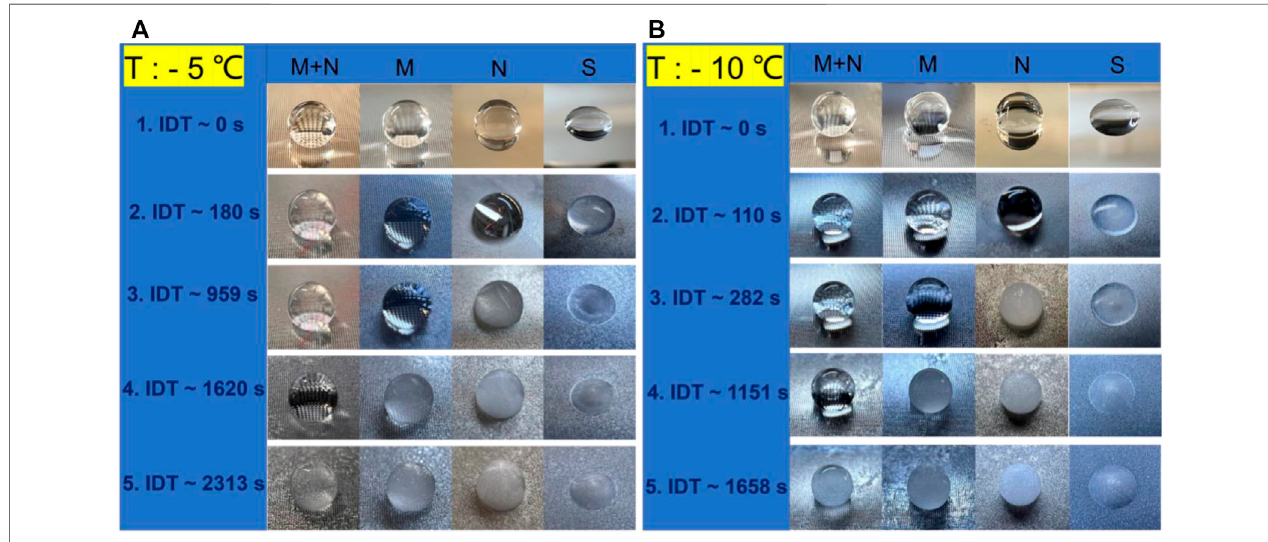
FIGURE 7 | Observations of ice formation on the differently structured surfaces at − 5 ° C and − 10 ° C cooling temperatures. From right to left are the photos of the droplets on the surfaces of S, N, M, and MN, respectively. (A) Record of ice formation and IDT at − 5 ° C: Frame 1 (IDT ~0 s) shows the water drop on the surface prior to the experiment;Frame 2,the dropleton Ssurface freezes at ~180 s IDT; Frame 3, the droplet on N surfacefreezesat ~959 s; Frame 4, the droplet on M surface freezes at ~ 620 s IDT; Frame 5, the droplet on MN freezes at ~2313 s IDT. (B) Record of ice formation and IDT at − 10 ° C with each frame showing a similar trend as (A) .